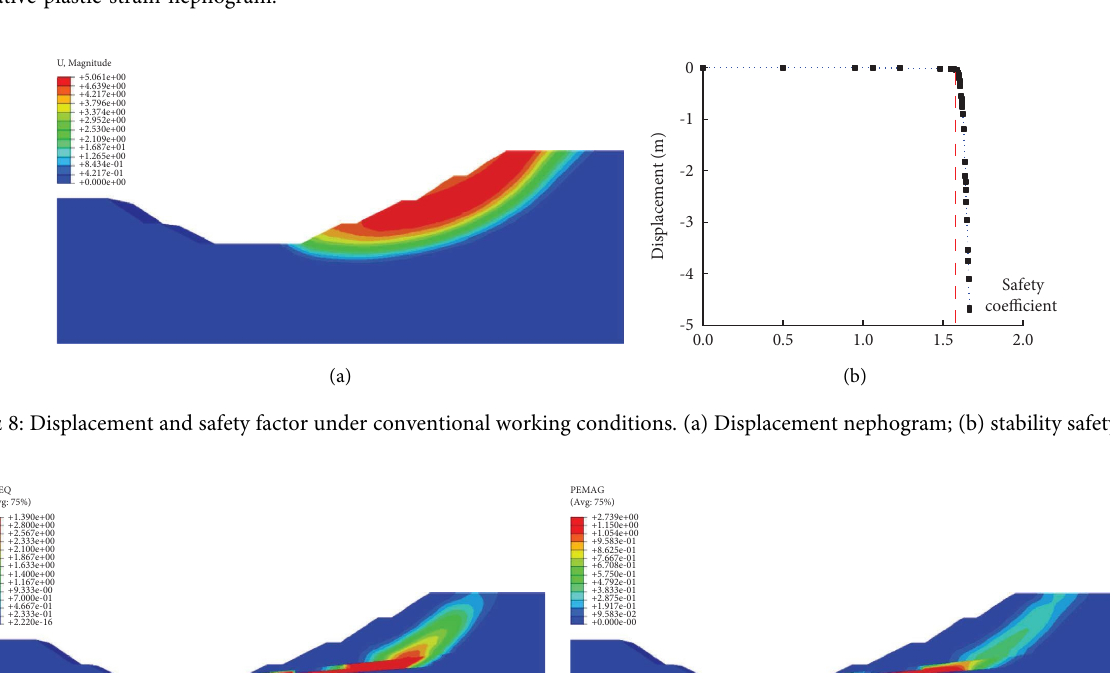
Figure 7: Te most dangerous sliding surface under conventional working conditions. (a) Equivalent plastic strain nephogram; (b) cumulative plastic strain nephogram.